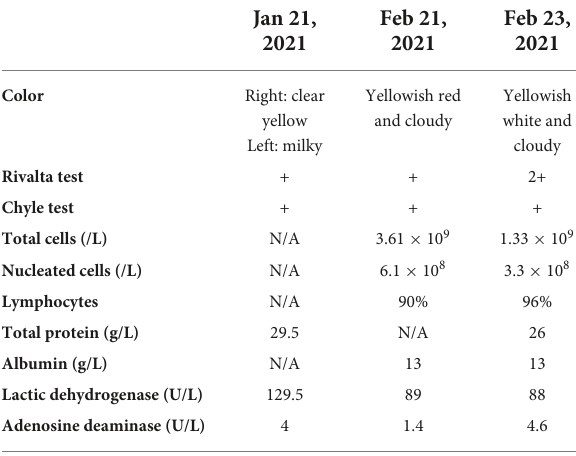
TABLE 1 Results of pleural effusion